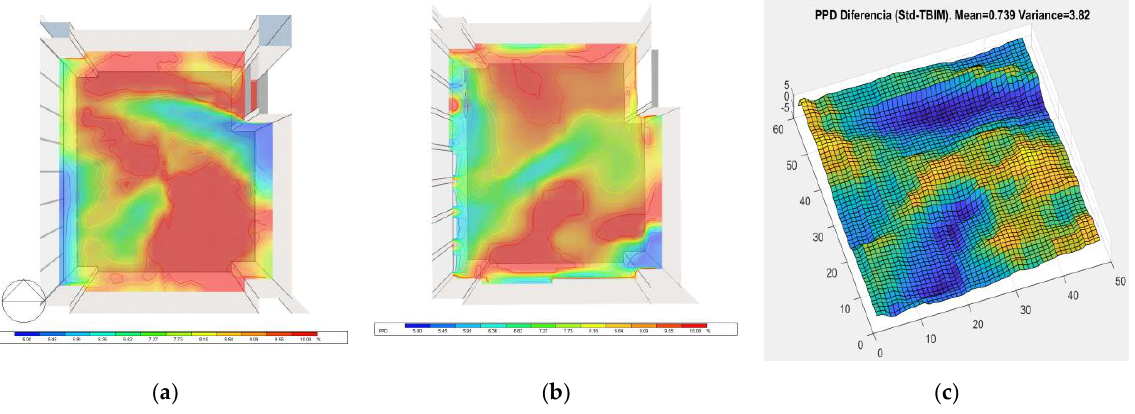
Figure 18. 2D graph maps of PPD comfort values on a horizontal plane at Z = 1.50 m, obtained by CFD simulation of atmospheric air flows, according to the conditions of Room W1, at 17 h, on 19 November TMY 2007 – 2021: ( a ) PPD of the as-is STD model; ( b ) PPD of the as-is T-BIM model; and ( c ) Point-to-point resolution of PPD differences in a comparison between both models.